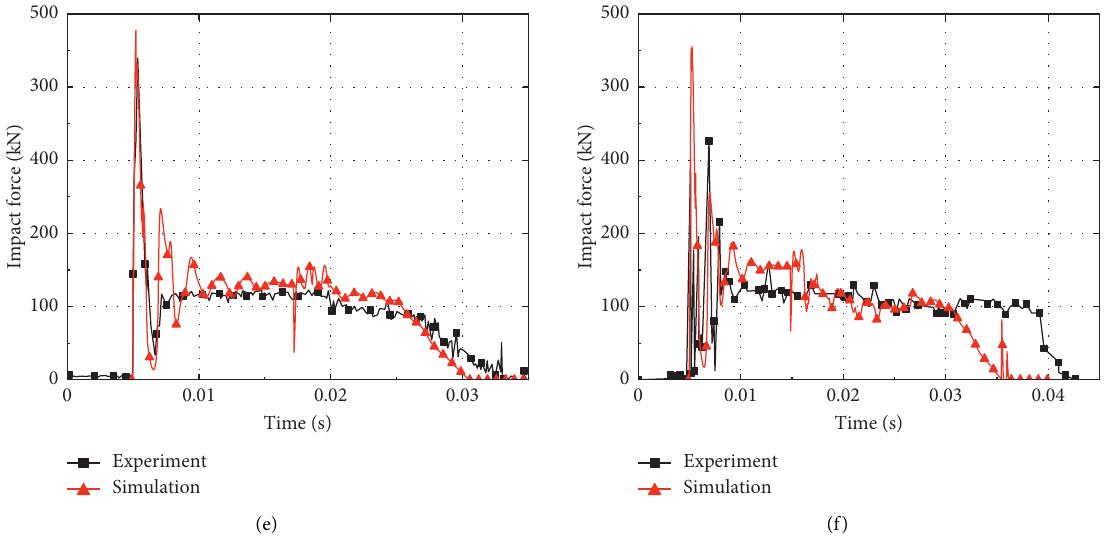
Figure 3: Impact force-time history curves of CFST members. (a) DBF14. (b) DBF13. (c) DBF19. (d) DZF22. (e) DZF26. (f) DZF31.